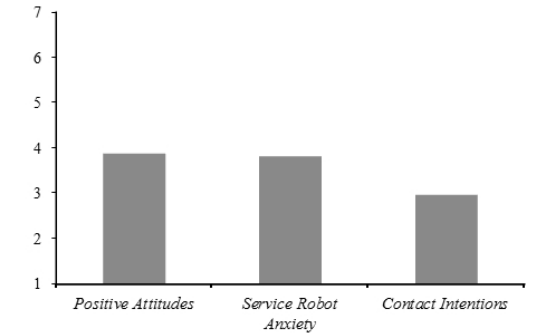
Figure 1. Mean values for Positive Attitudes , ServiceRobot Anxiety , and Contact Intentions